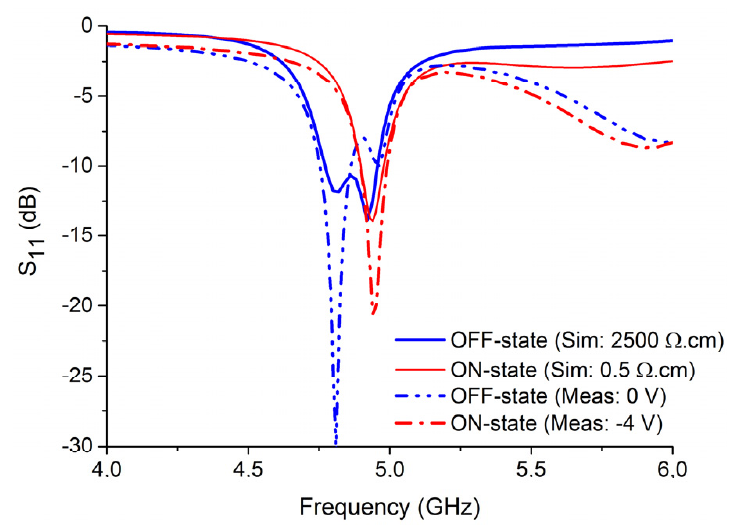
shown in Figure 15.